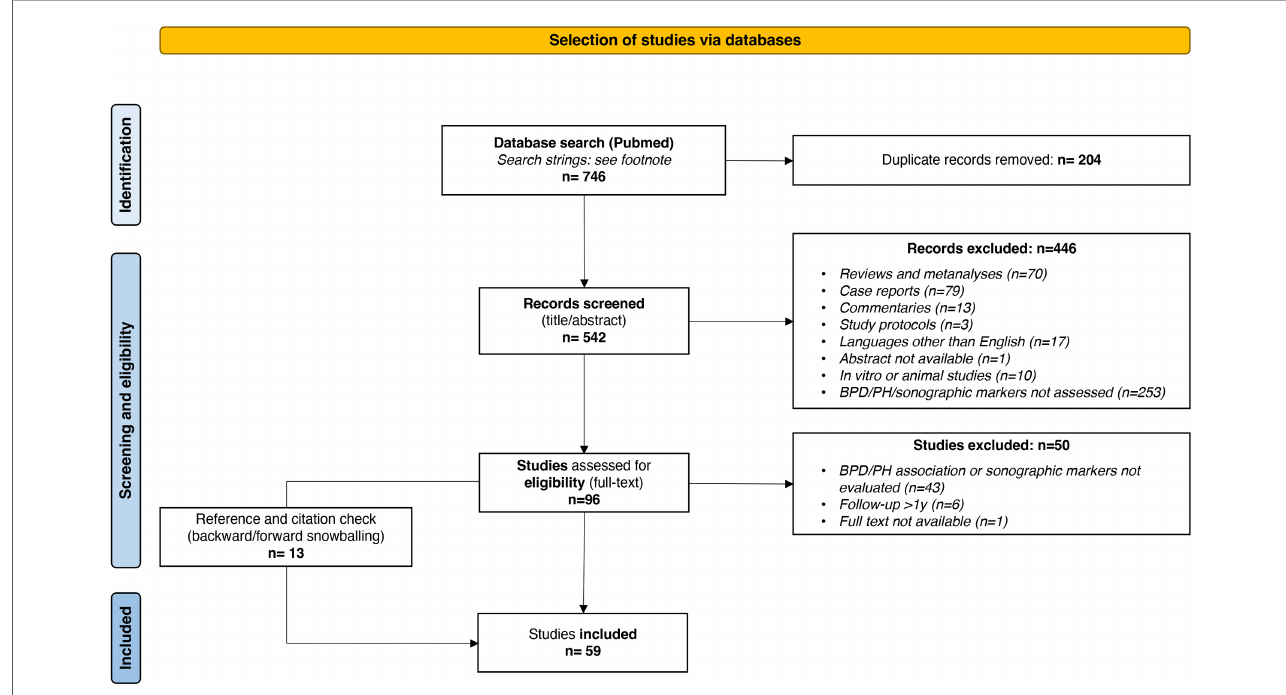
FIGURE 11 PRISMA fl ow diagram detailing the search and selection process applied for literature